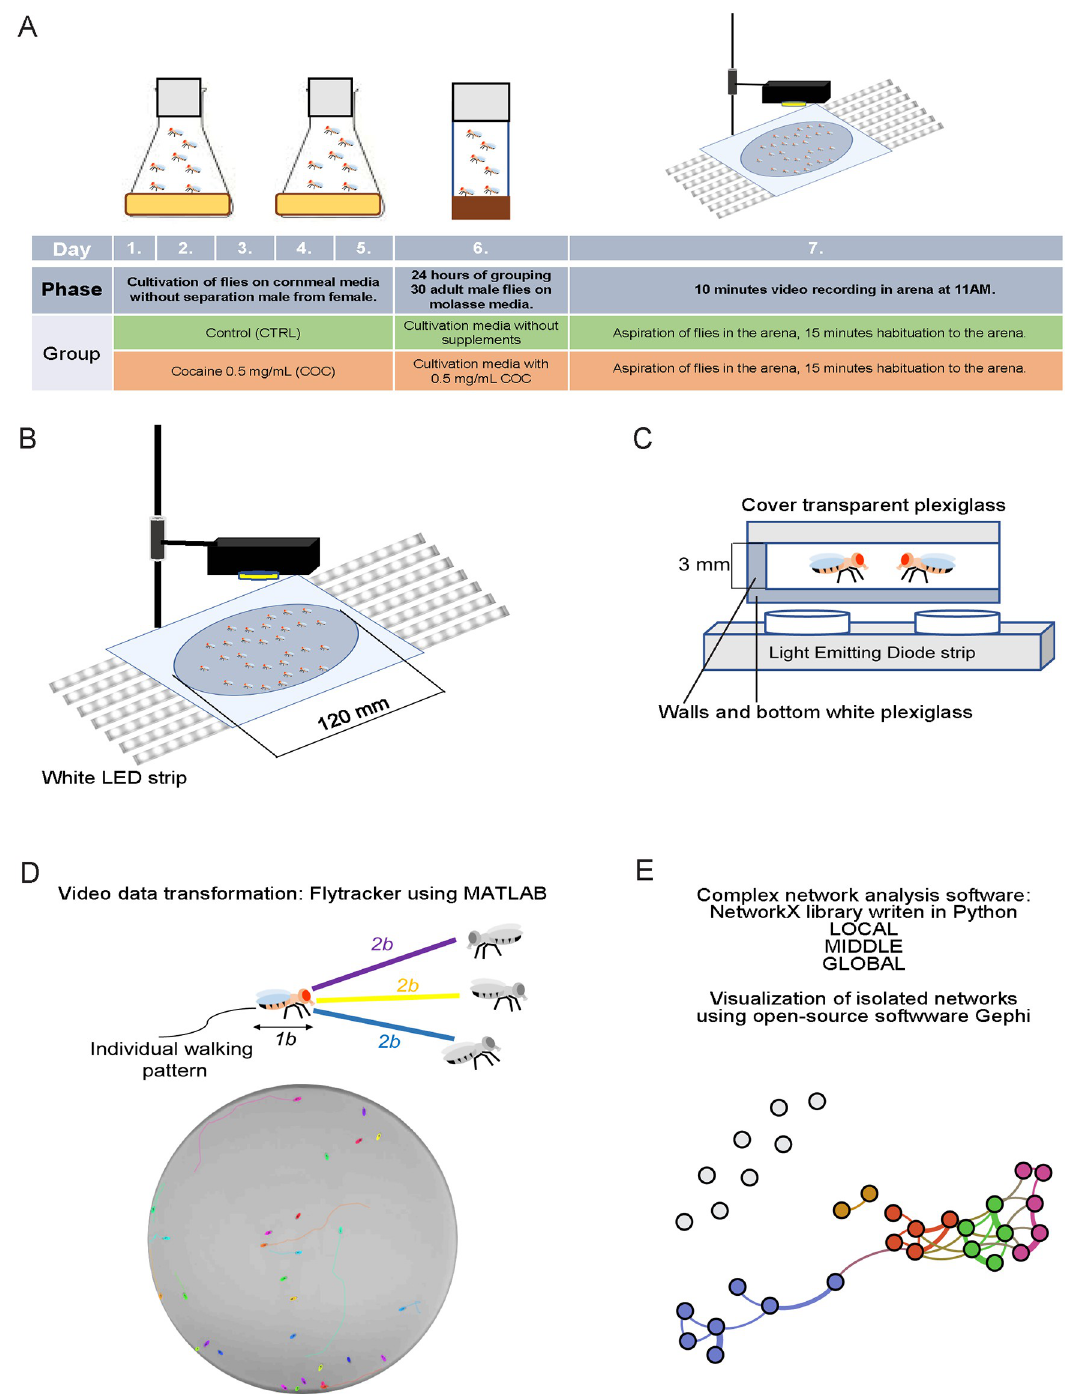
Fig 1. Experimental setup. A) Timeline of the experiment. B) Graphical representation of the video recording setup. 30 flies were recorded for 10 minutes in a 120 mm diameter circular arena with a bottom made of white Plexiglas illuminated with a white LED strip. C) Cross section of the arena. The outer cover of the arena is made of transparent Plexiglas placed at a height of 3 mm, to allow movement of flies in two dimensions only. D) Distance interaction threshold and possible types of interactions between two flies extracted from the video recording shown in the circle. The size of one fly is considered as one body length (1b) which is approximately 2 mm. An interaction threshold of two body lengths (2b) or 4 mm was used where one fly (the interactor fly shown in color) approaches another fly (the interacted fly shown in gray) in various orientations. Possible interactions are: head-to-head